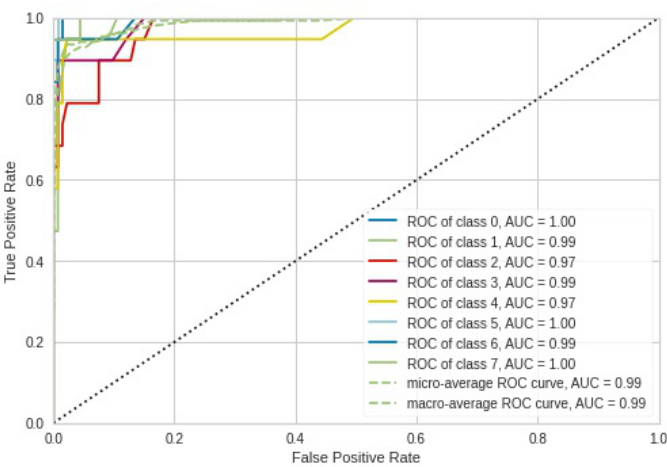
Figure 12. ROC AUC Curves for Random-Forest-based classifier.